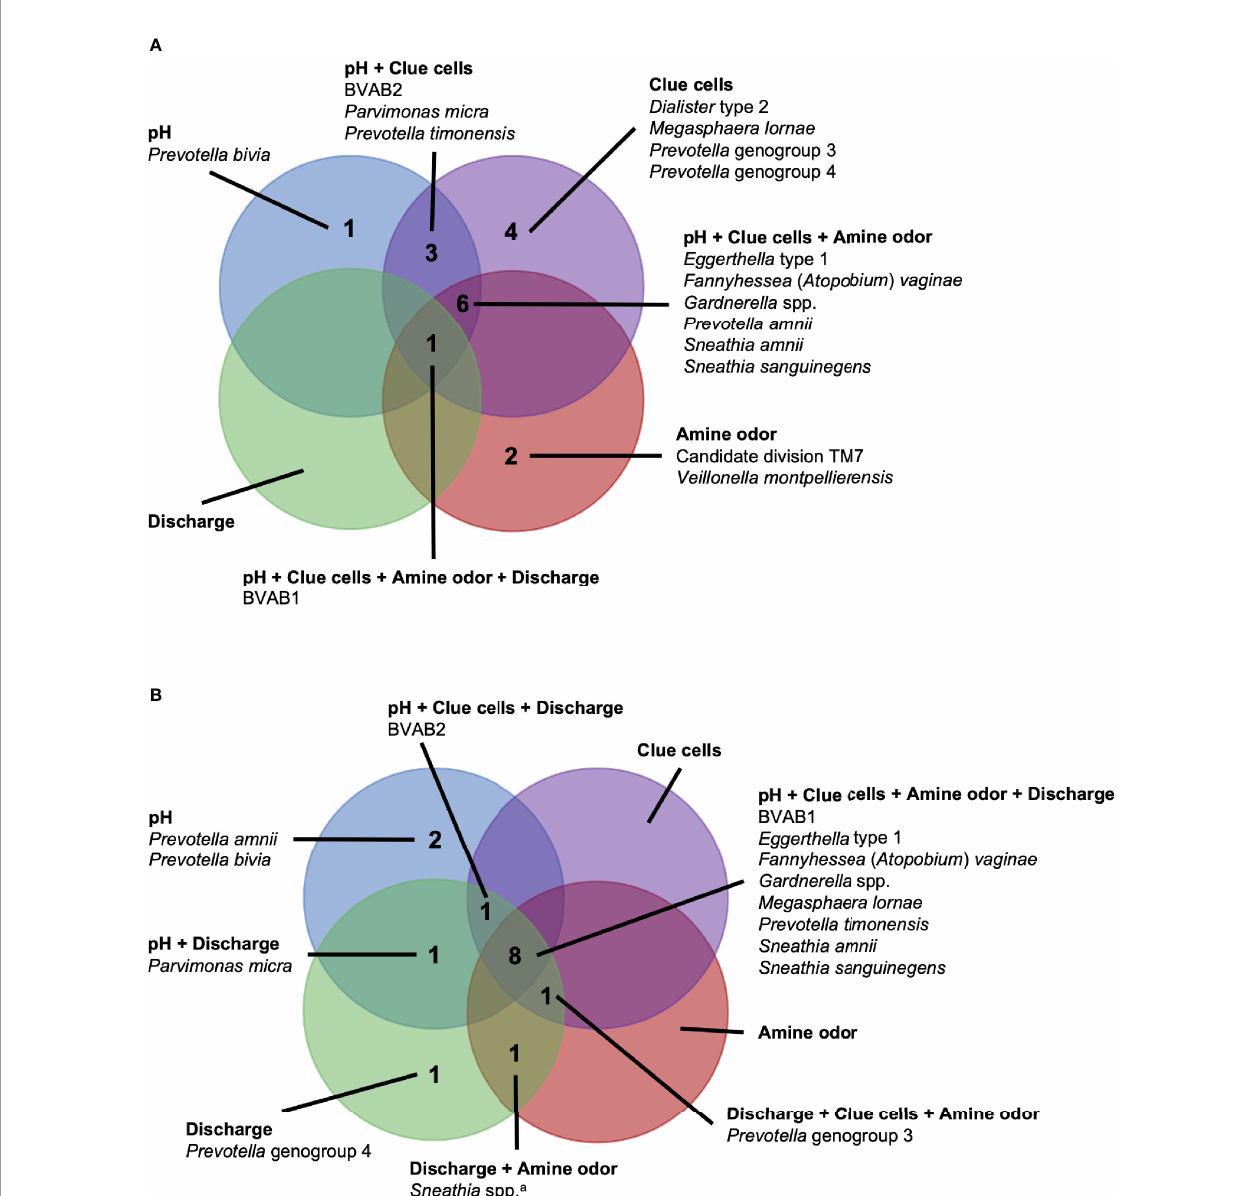
FIGURE 6 | Vaginal bacteria signi fi cantly positively associated with Amsel criteria in the PVI trial population and Seattle study population. Vaginal bacteria signi fi cantly positively associated with at least one Amsel criterion in (A) the PVI trial population and (B) the Seattle study population. Results are from logistic regression models fi t separately for each study population. In each model, a single Amsel criterion was the outcome, and a single bacterial taxon was the exposure. Bacterial relative abundances were modeled as tertiles with the reference level being no detection (four-level ordinal variables with levels: no detection, tertile 1, tertile 2, tertile 3). Generalized estimating equations with an independent correlation structure were used for PVI trial models, and no variables were lagged in PVI trial models. All models were univariable. All associations represented in the Venn diagrams were signi fi cant following Benjamini-Hochberg multiple comparisons adjustment (5% false discovery rate). a Sneathia spp. includes those not classi fi ed at the species level as S . amnii or S . sanguinegens , but closely related to these two species. Sequences are not suf fi ciently different at the V3-V4 region of the 16S rRNA gene to classify at the species level, hence classi fi ed at the genus level. PVI, Preventing Vaginal Infections; BVAB, bacterial vaginosis associated